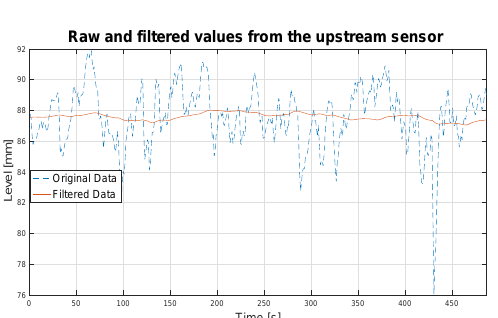
Figure 10: Flow estimation for multiple discharges